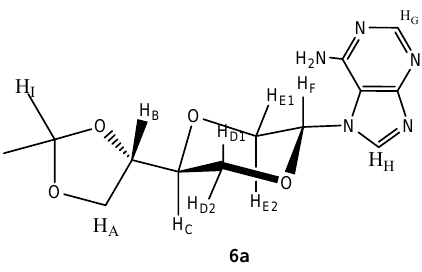
Figure 2. Structure of compound 6a .